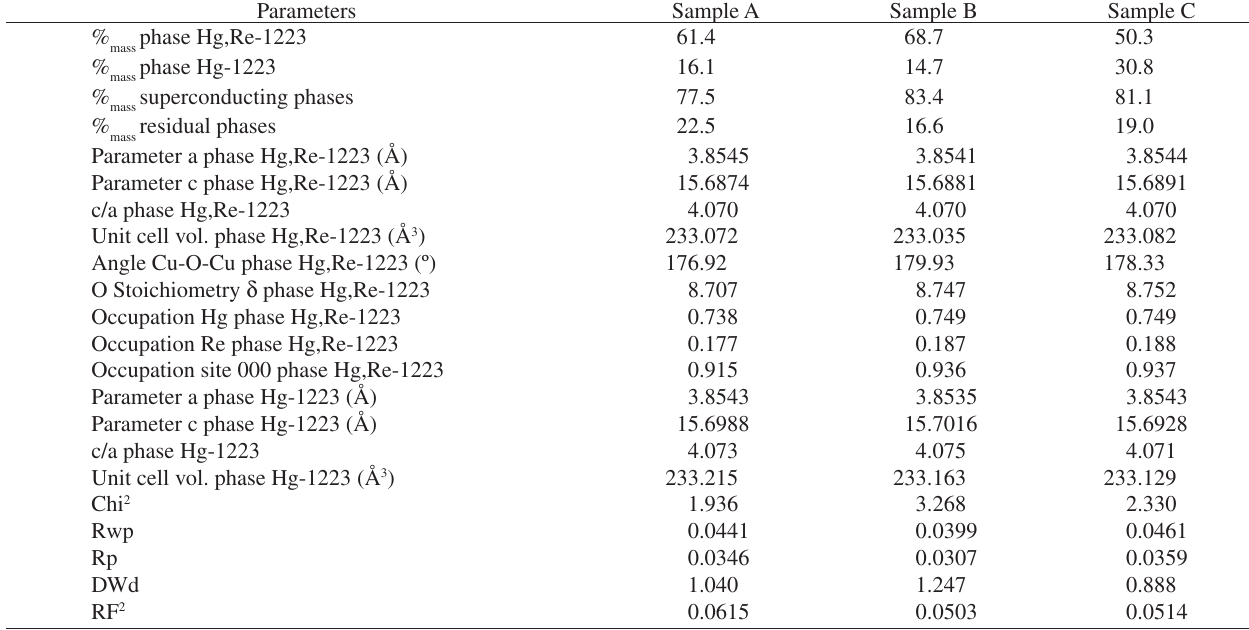
Table 4. Main results of Rietveld fits for the samples A, B and C. Parameters